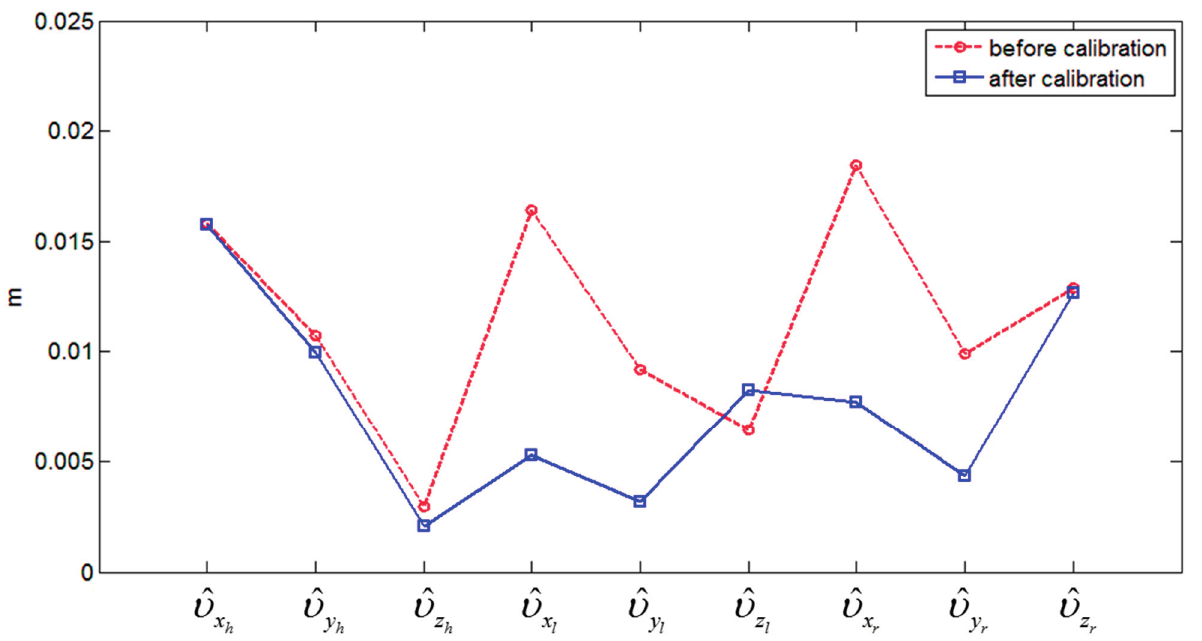
Figure 16. Cross-section view of the point-cloud data acquisition before (green) and after the constrained calibration (red).